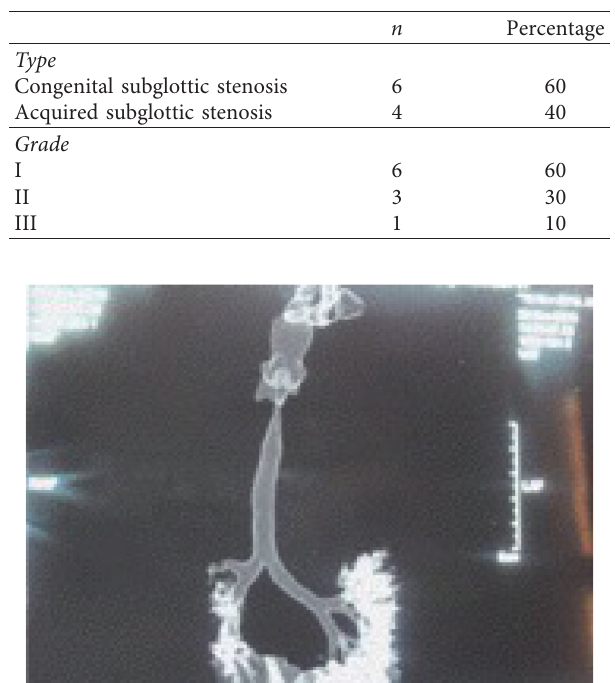
Table 2: Type and grade of subglottic stenosis.